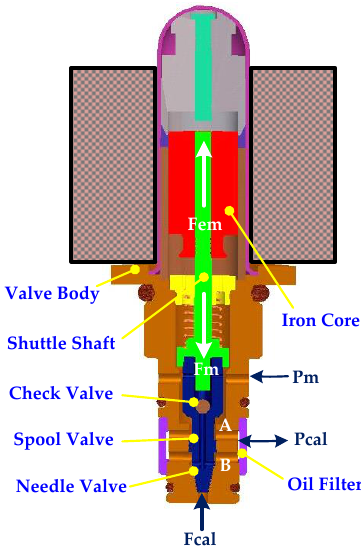
Figure 4. The structure of the proportional valve body for a PEHB.